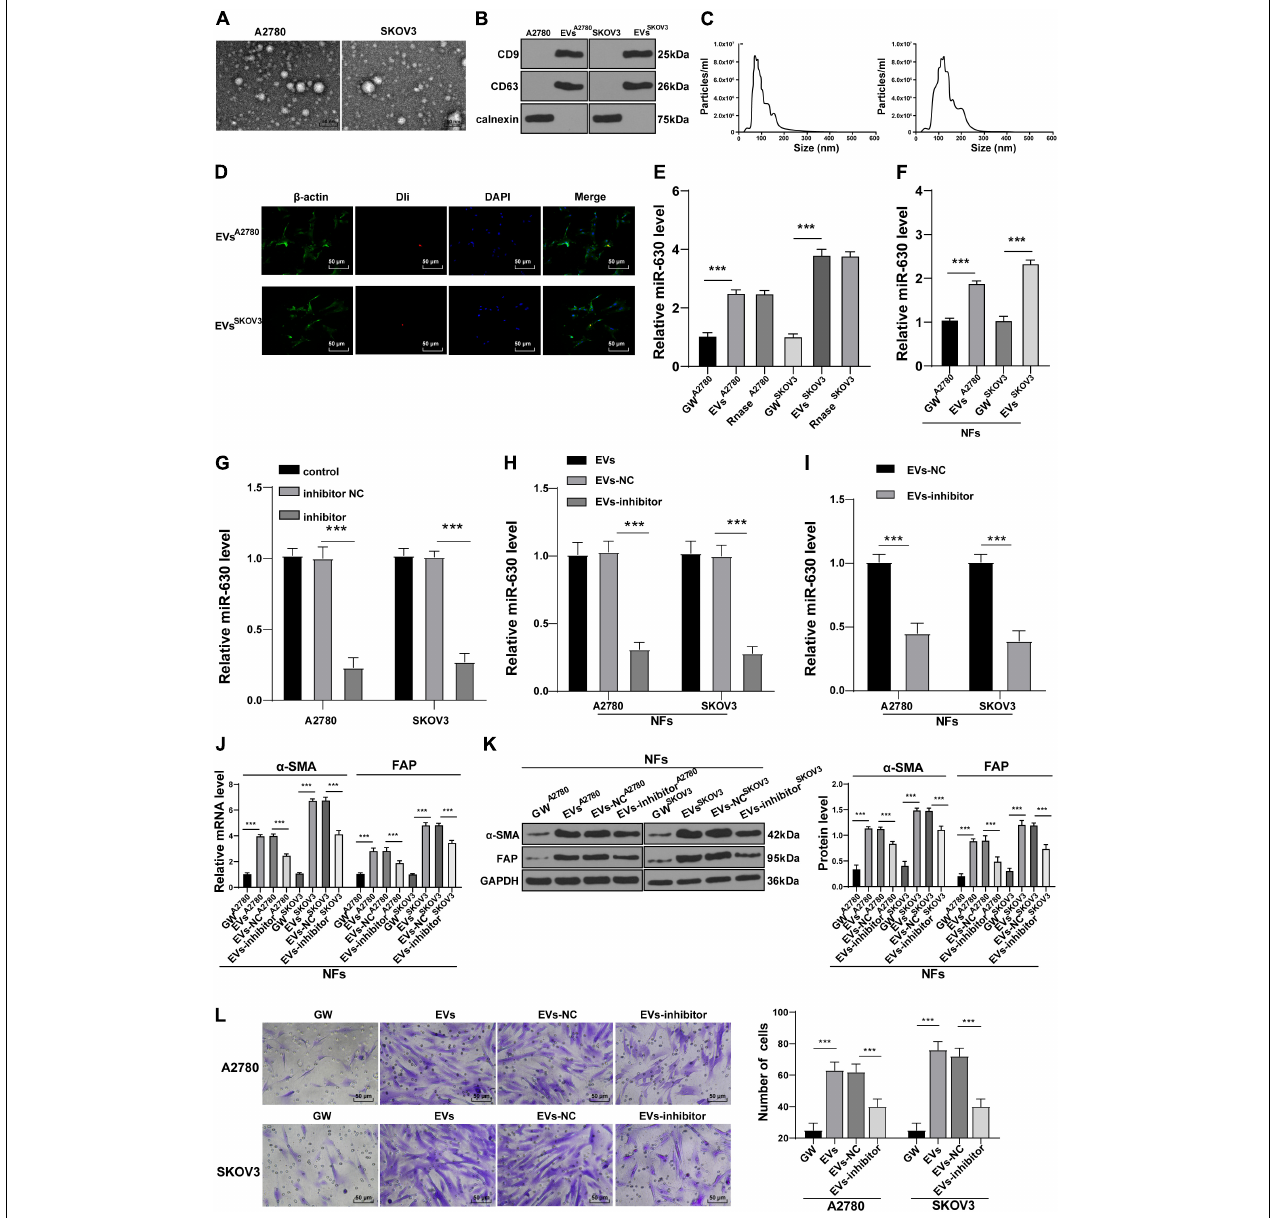
FIGURE 3 | Extracellular vesicles carried miR-630 into NFs and promoted their transformation into CAFs. Untreated or transfected with miR-630 inhibitor or its NC A2780 and SKOV3 cells were collected, and then EVs were extracted. (A) Morphology of A2780 and SKOV3 cells-derived EVs was observed under TEM; (B) expression of CD9, CD63 and calnexin on EVs was detected using Western blotting; (C) concentration and particle size of EVs were measured using NTA; (D) NFs were cultured with Dil-labeled EVs and observed under the fluorescent microscope; (E) Expression of miR-630 in EVs was detected using RT-qPCR. NFs were treated with extracted EVs. (F) Expression of miR-630 in EVs-treated NFs was detected using RT-qPCR; (G,H) transfection efficiency of miR-630 inhibitor was confirmed and miR-630 expression in EVs was detected using RT-qPCR; (I) expression of miR-630 in EVs-inhibitor-treated NFs was detected using RT-qPCR; (J,K) levels of CAFs marker proteins ( α -SMA and FAP) in NFs were detected using RT-qPCR and Western blotting. (L) Migration of NFs in each group was detected using Transwell assay; the migrated cells were counted and representative images were displayed. The experiment was repeated three times independently. Data are presented as mean ± standard deviation. Data in panels (E–L) were analyzed using one-way ANOVA, followed by Tukey’s multiple comparison test, *** p < 0.001. A2780 and SKOV3 in the panels indicated the source of EVs, except for panel (G)